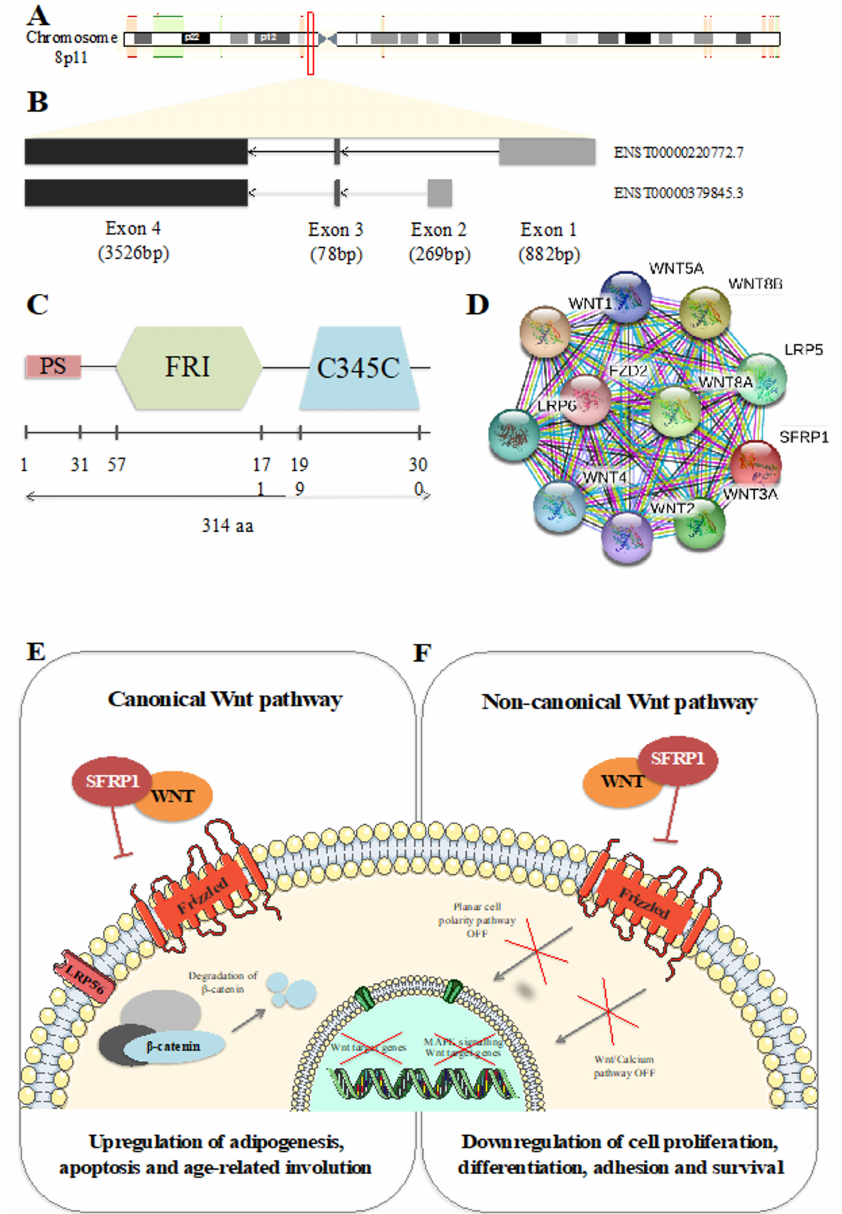
Figure 1. Secreted frizzled-related protein 1 ( SFRP1 ) identity. ( A ) Schematic representation of SFRP1 position on chromosome 8. ( B ) Schematic representation of SFRP1 isoforms. ( C ) Schematic representation of SFRP1 protein domains. ( D ) Top 10 of protein–protein interactions between SFRP1 and Wnt signaling pathways. Figure drawn using Simple modular architecture research tool (SMART) [7]. Wnt canonical ( E ) and non-canonical ( F ) pathways in physiological